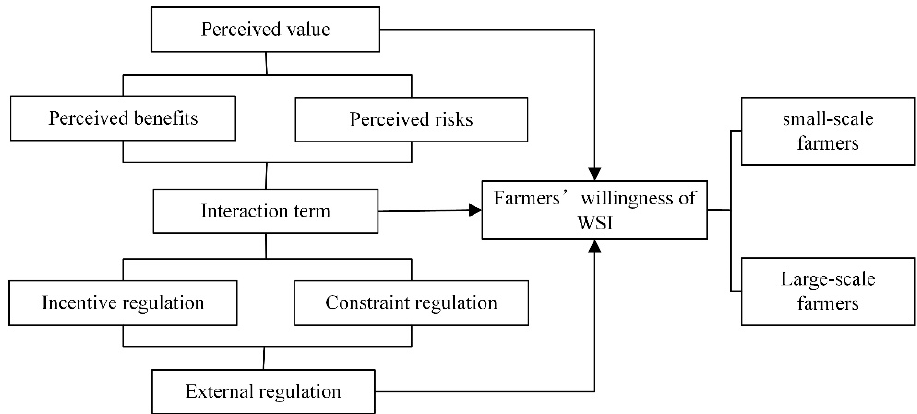
Figure 1. Analytical framework.